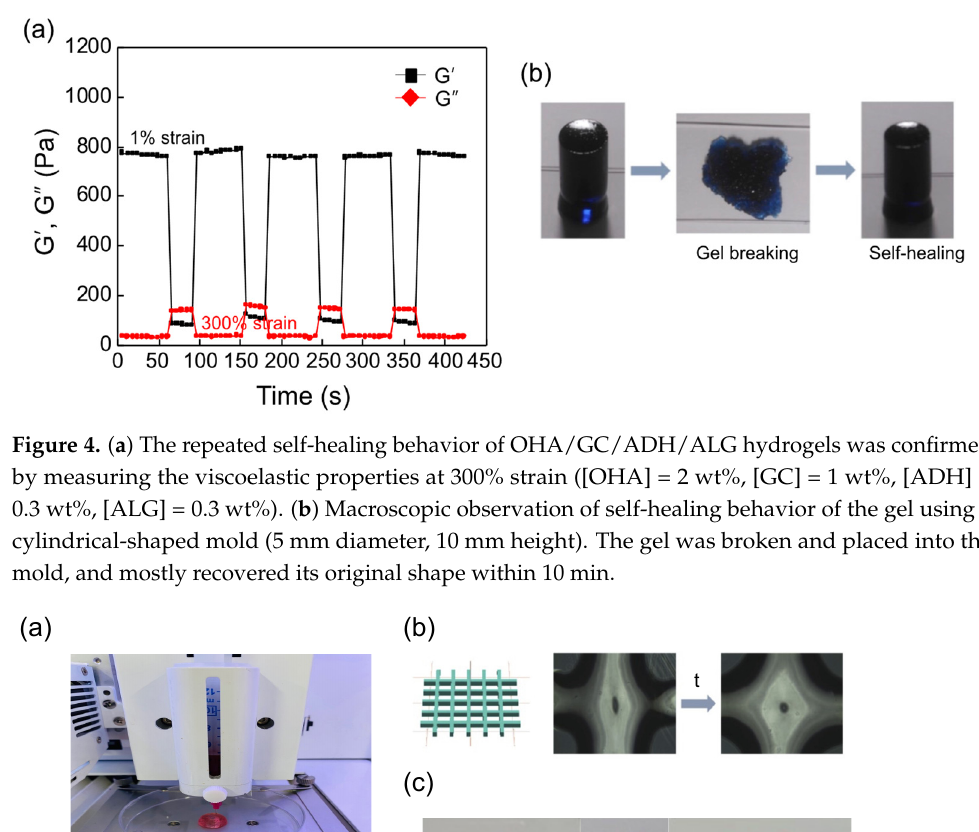
Figure 4. ( a ) The repeated self-healing behavior of OHA/GC/ADH/ALG hydrogels was confirmed by measuring the viscoelastic properties at 300 % strain ([OHA] = 2 wt%, [GC] = 1 wt%, [ADH] = 0.3 wt%, [ALG] = 0.3 wt%). ( b ) Macroscopic observation of self-healing behavior of the gel using a cy- lindrical-shaped mold (5 mm diameter, 10 mm height). The gel was broken and placed into the mold, and mostly recovered its original shape within 10 min.